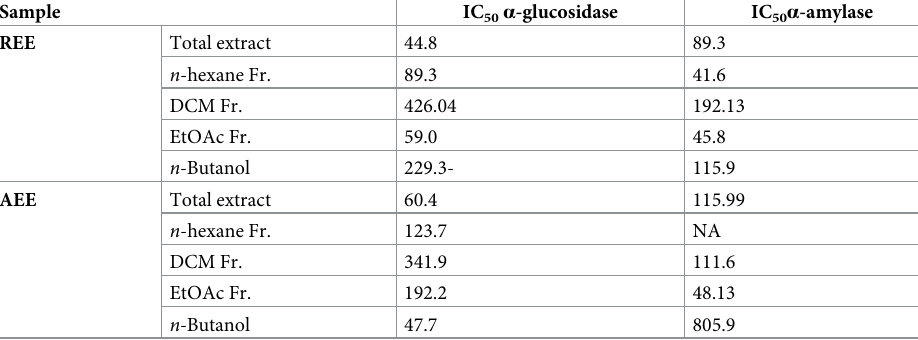
Table 5. α -glucosidase and α -amylase inhibitory activity of REE and AEE and their fractions measured as IC 50 ( μ